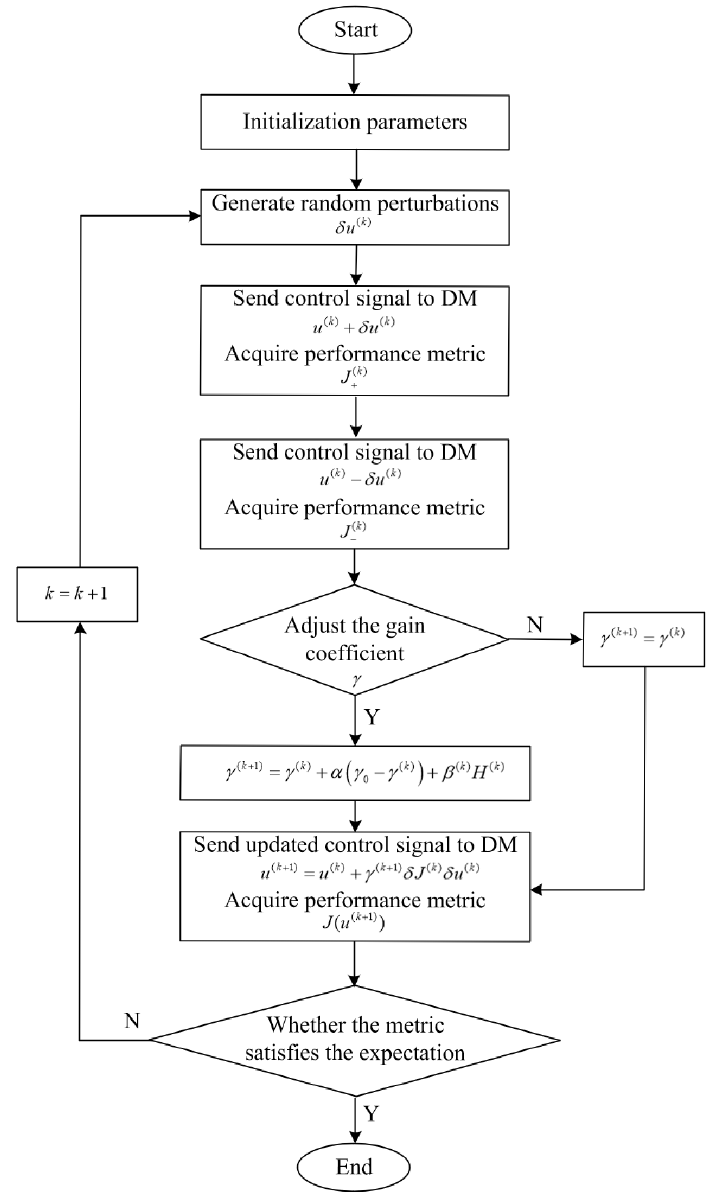
Figure 2. Flow of SPGD algorithm for LSCM.